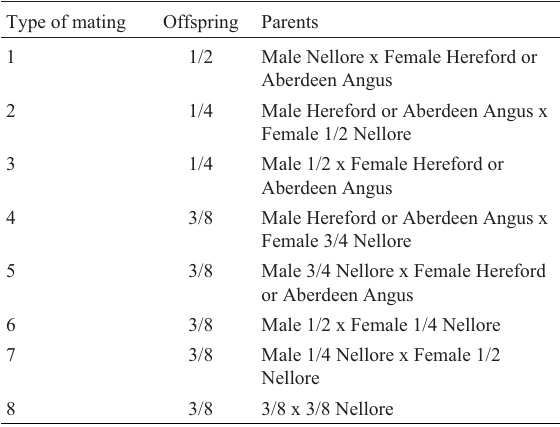
Table 1 - Matings used to obtain Braford (5/8 Hereford x 3/8 Nellore) and Brangus-Ibagé (5/8 Aberdeen Angus x 3/8 Nellore) synthetic